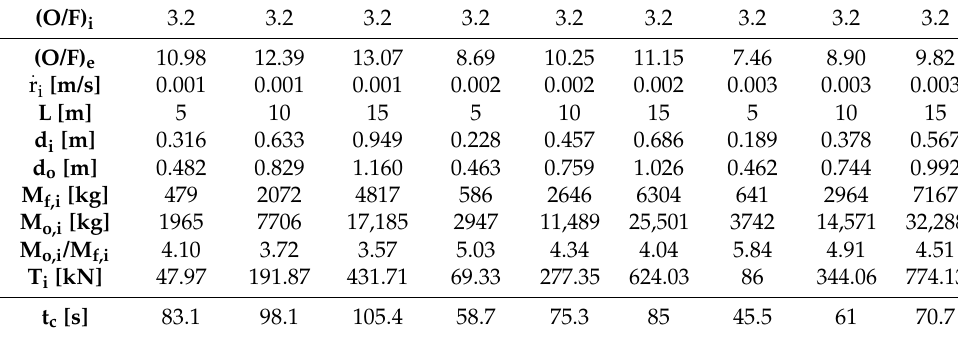
Table 3. Numerical results for R TM,i = 2.0 and imposed L and